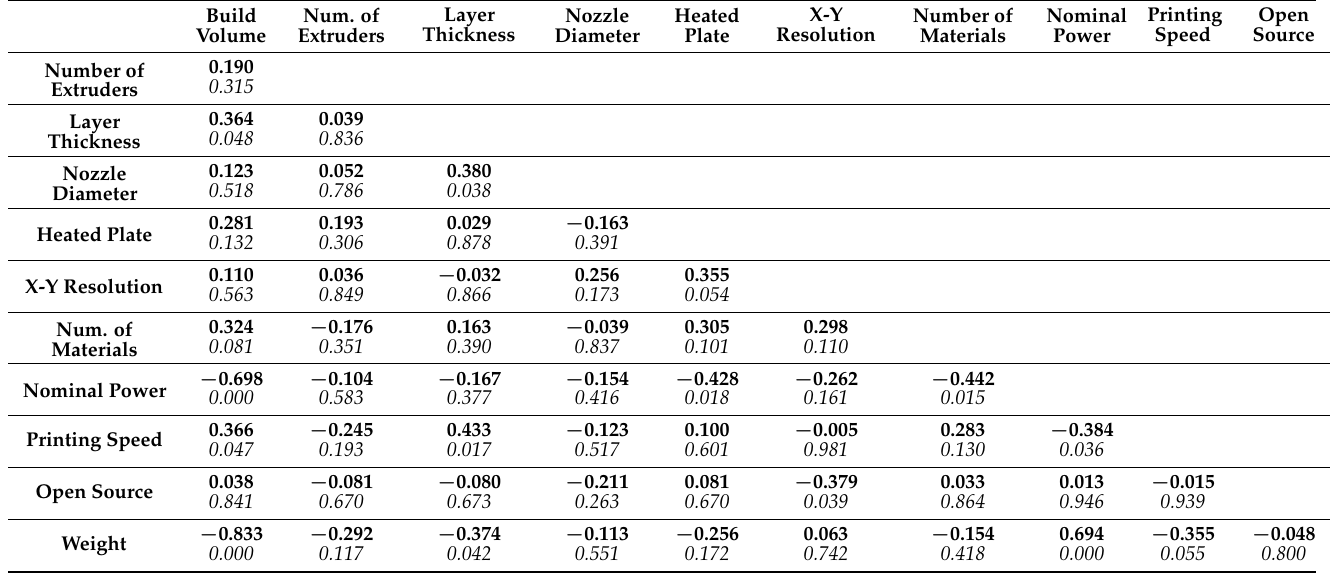
Table 3. Correlation coefficient (in bold) and p -value (in italics) for 3D printer output parameters.